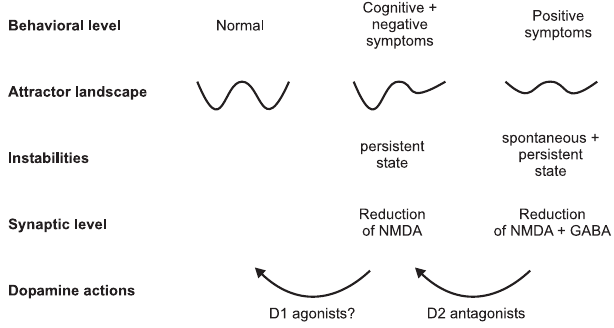
Figure 7. Summary of the Attractor Hypothesis of Schizophrenic Symptoms and the Simulation Results The first basin (from the left) in each energy landscape is the spontaneous state, and the second basin is the persistent attractor state. The vertical axis of each landscape is the energy potential. See text for simulation